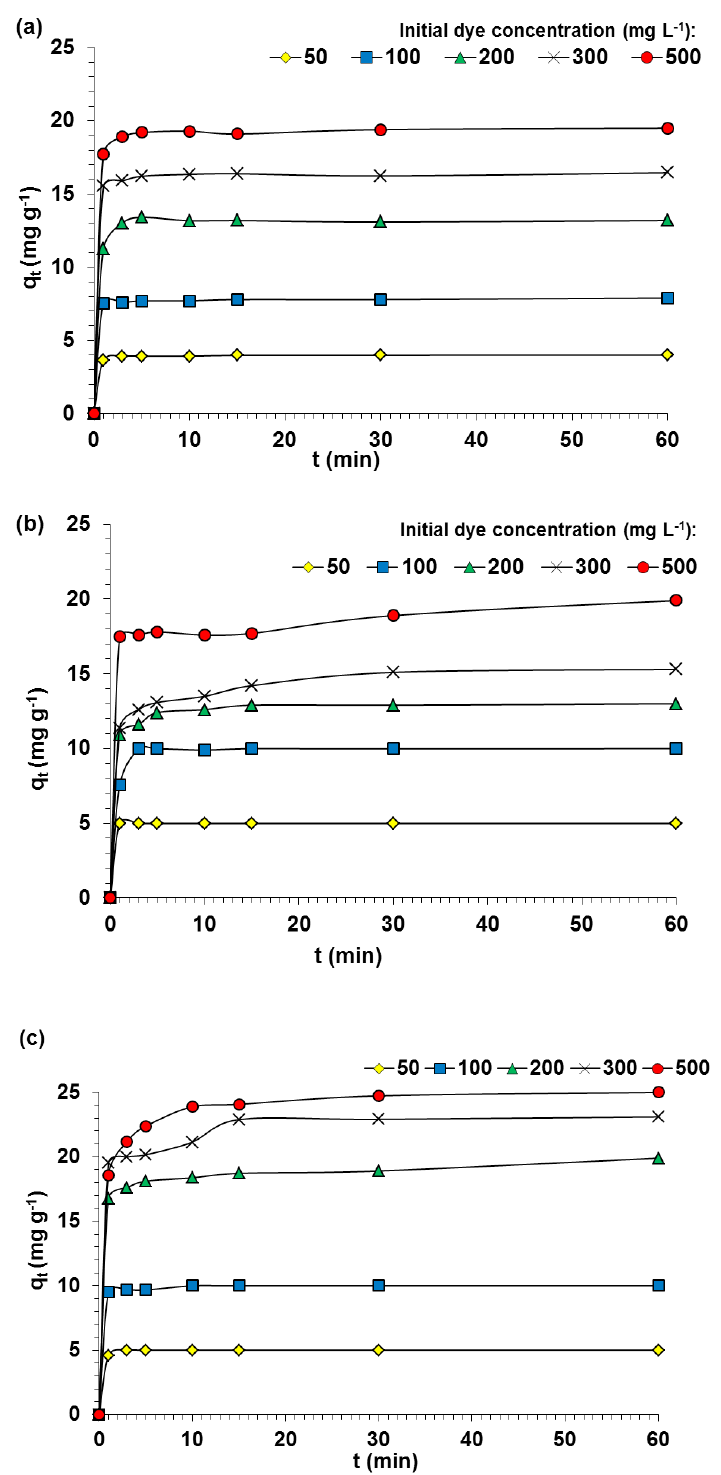
Figure 2: Kinetic curves of C.I. Acid Orange 7 (a), C.I. Reactive Black 5 (b) and C.I. Direct Blue 71 (c) sorption on the aminosilane modified silica ( conditions: initial dyes concentrations: 50-500 mg L -1 , volume: 50 mL, sorbent mass: 0.5 g, agitation speed: 180 rpm, temperature: 25 o